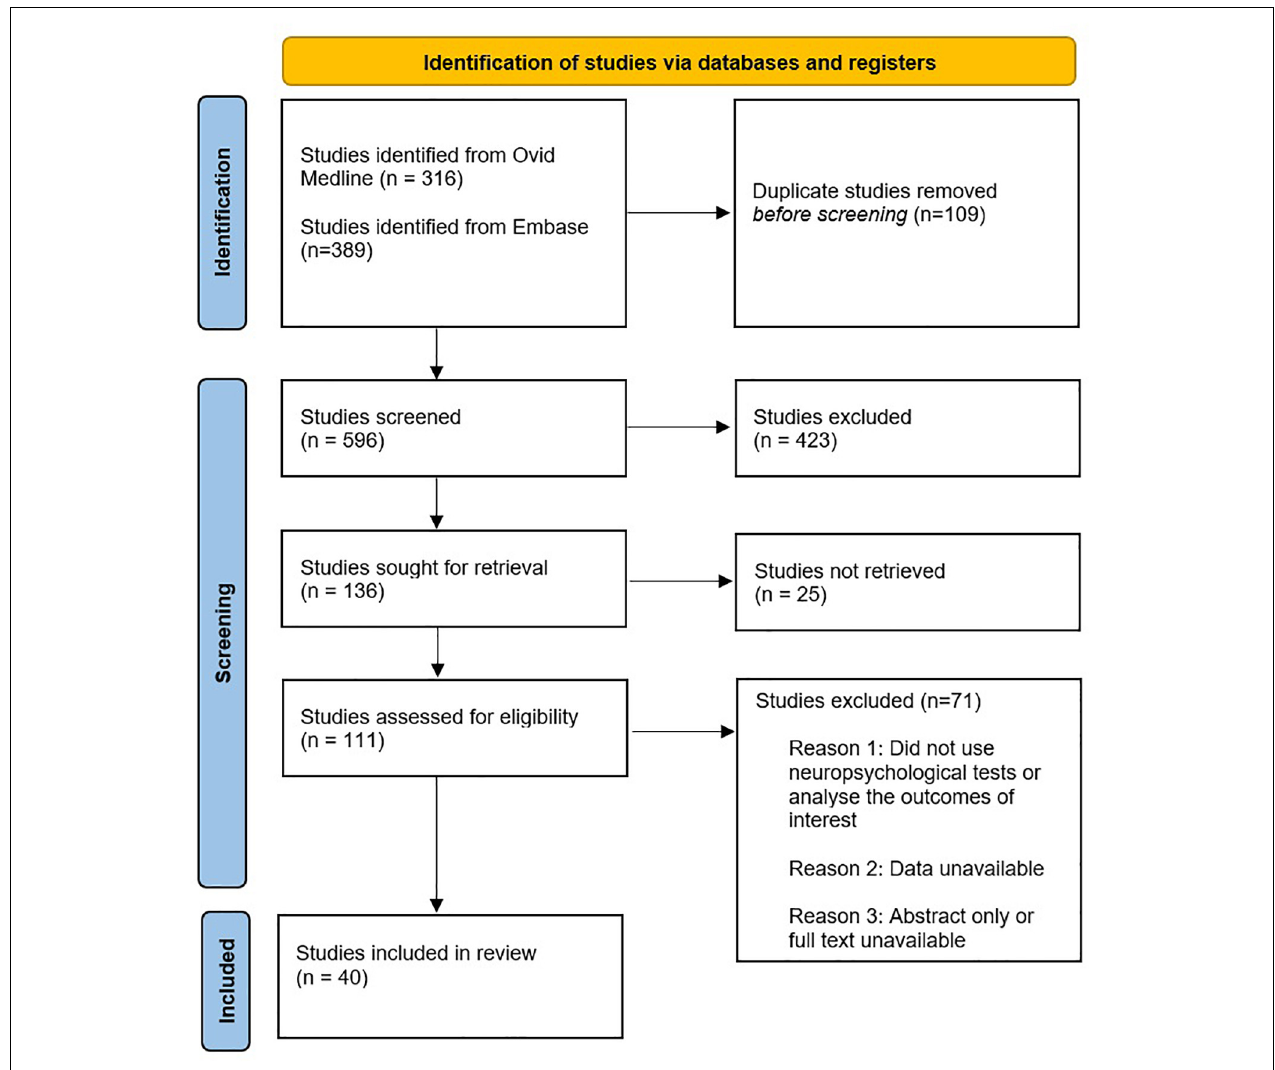
FIGURE 1 | The identification and selection of studies included in this narrative